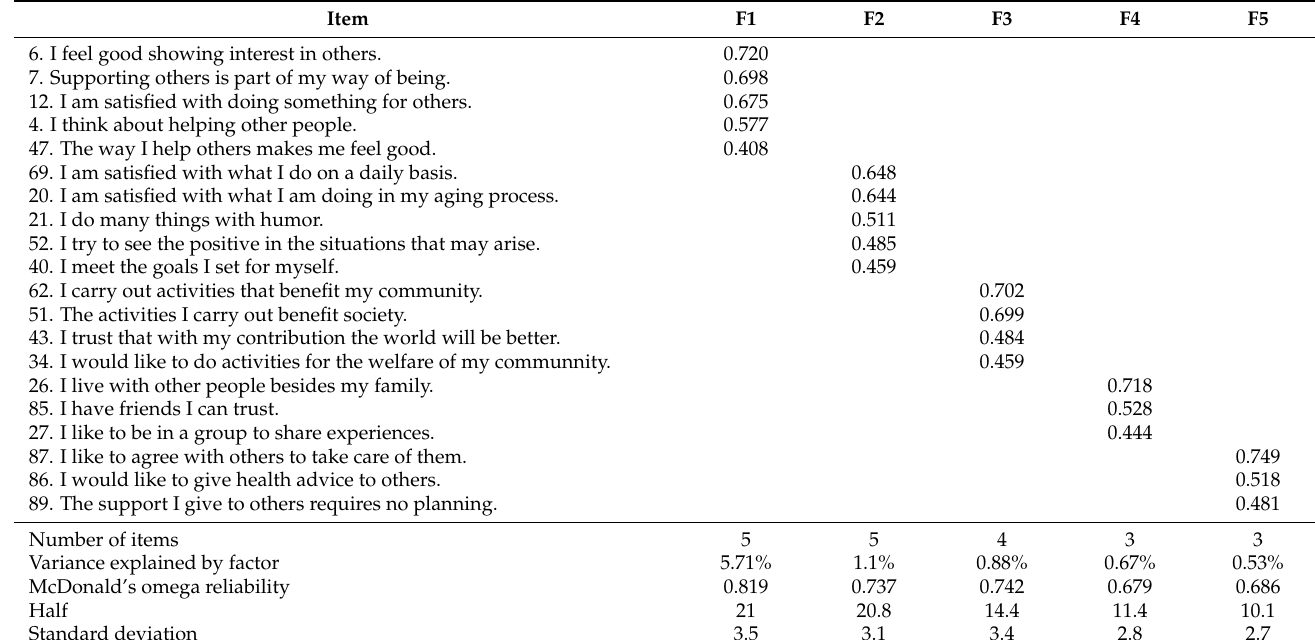
Table 2. Factor analysis with the unweighted least-squares extraction method explained variance, reliability index, mean, and standard deviation of the scale items ( n = 450). F1 F2 F3 F4